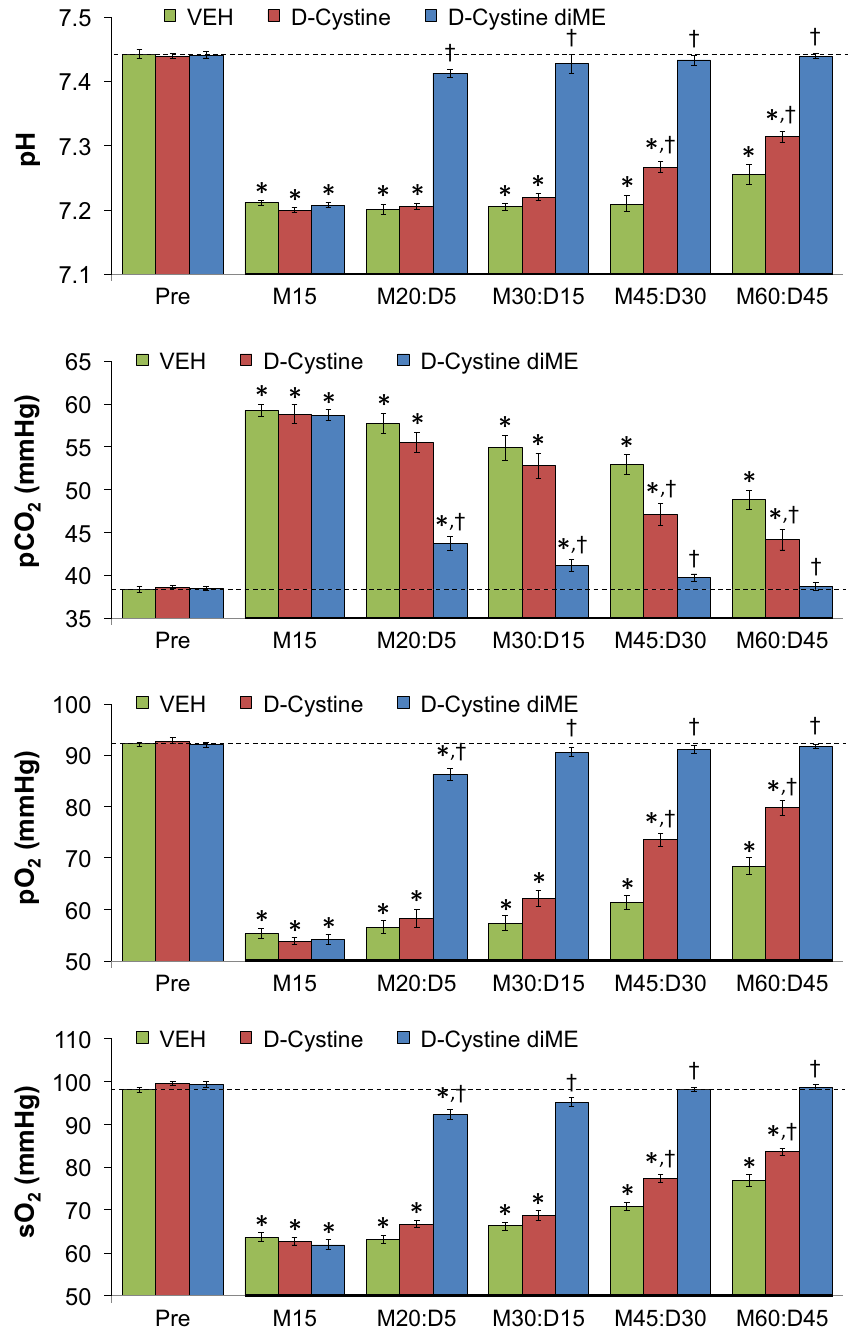
Figure 5. Changes in pH, pCO 2 , pO 2 and sO 2 elicited by injection of morphine (10 mg/kg, IV) in 3 separate groups of freely moving rats followed by injection of vehicle (VEH, saline), d-Cystine (500 μmol/kg, IV) or d-cystine dimethyl ester (d-cystine diME, 500 μmol/kg, IV). M15–M60, 15–60 min after injection of morphine. D5–D45, 5–45 min after injection of drug (vehicle, d-Cystine or d-cystine diME). The data are shown as mean ± SEM. There were 9 rats in each group. *P < 0.05, significant change from Pre-values. † P < 0.05, d-cystine diEE versus